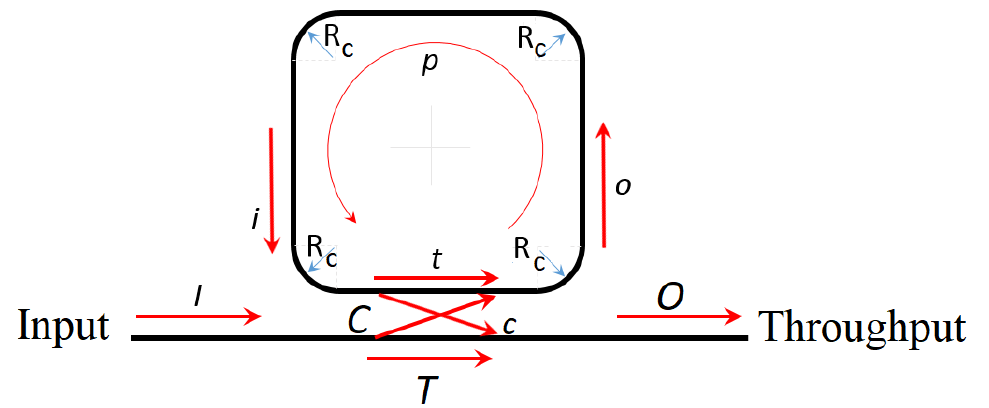
Figure 1. Schematic of a planar waveguide-coupled RCSS microresonator channel. The complex output fields O and o are related to the complex input fields I and